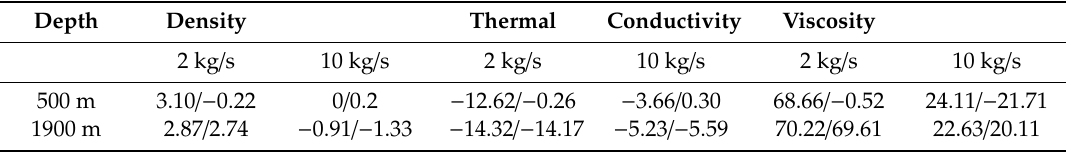
Table 4. Error between the constant values and the IAPWS-IF97 in the vertical axis for the density, thermal conductivity and viscosity (in %). The left side of each cell (3.1 / ) is for the production well and right side ( / − 0.22) is for the annulus. The negative values are set for lower values using the IAPWS-IF97 properties compared to the constant